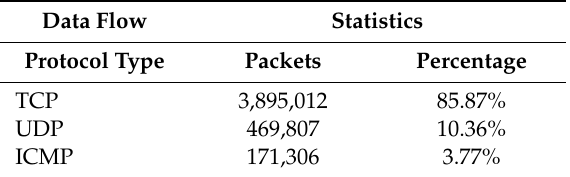
Figure 3 Flow duration and inter arrival time